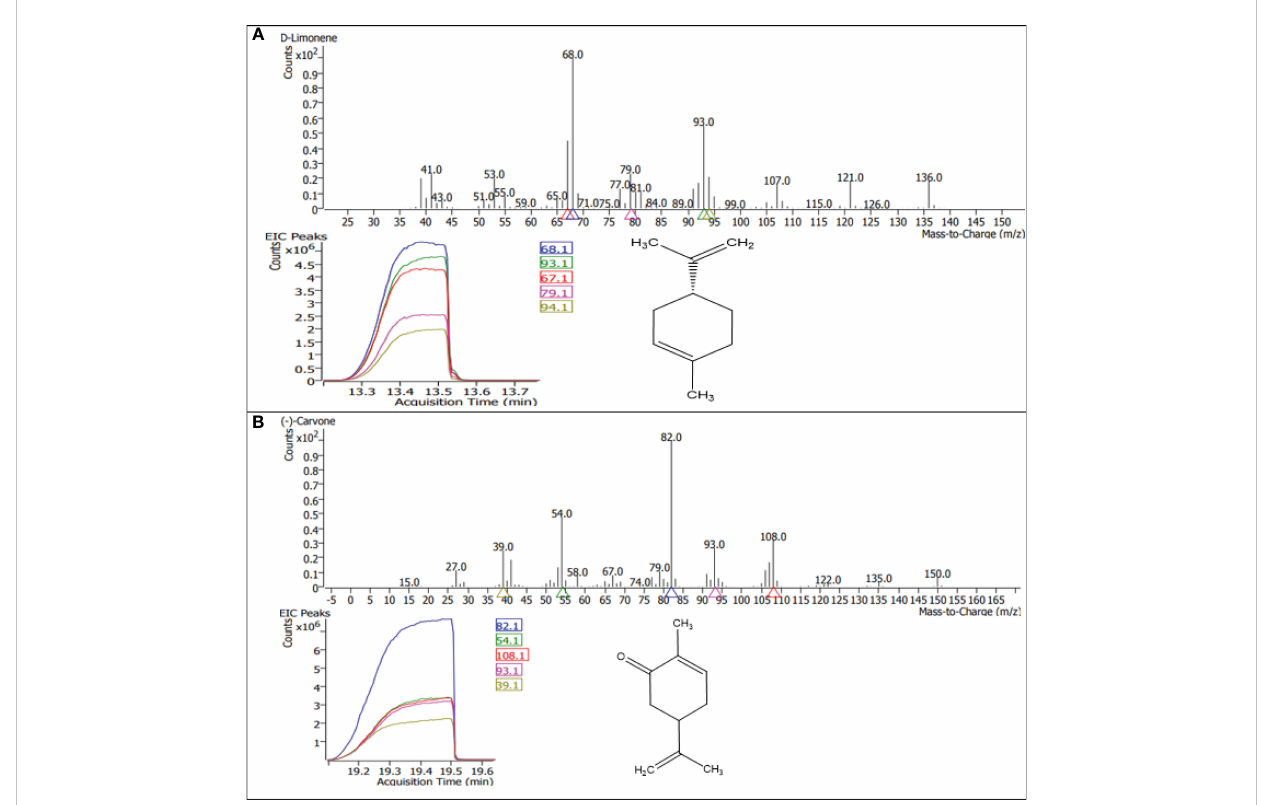
FIGURE 9 GC – MS chromatograms of the dominant compounds (A) limonene and (B) carvone of essential oil in M. longifolia .